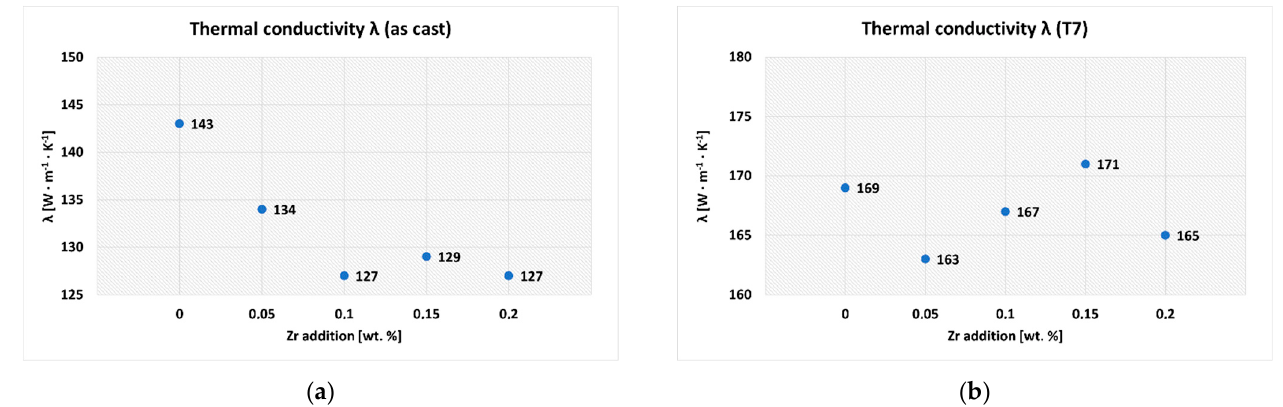
Figure 9. Thermal conductivity of the experimental alloys: ( a ) as ‐ cast state; ( b ) after T7 heat treatment.